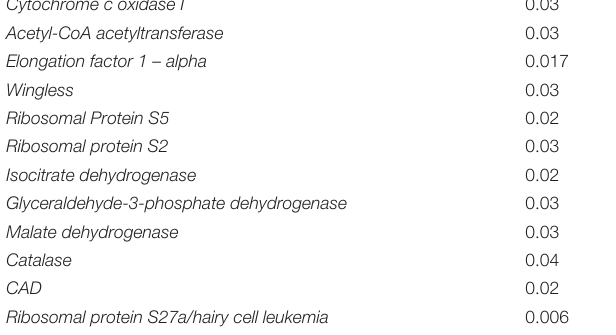
ranged between 0.04 and 0.09 and were found to be consistently lower for functional domains compared to the gene-wide values ( Table 1A ). Similarly, R values for genes used in species-level phylogenetic reconstruction were considerably lower and ranged between 0.006 and 0.04. We observed that the non-synonymous substitution rate was lowest in pale , followed by black and DDC ( Figure 2 , p < 0.05). Since DDC , black, and pale are essential for the synthesis of dopamine—a precursor for multiple pathways including neuromodulation, immune functions, and the circadian cycle (Basu and Dasgupta, 2000; Allen et